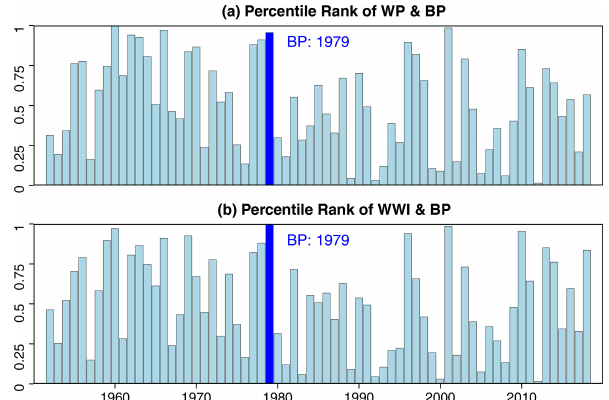
Figure 3. The percentile rank of (a) average wintertime precipita- tion (WP) and (b) wintertime water inflows (WWIs) in the NEN- WIRES dataset during the period from 1952 to 2018. Vertical dark blue lines represent the most probable breakpoint (BP) detected us- ing the Pettitt homogeneity test (Sect.